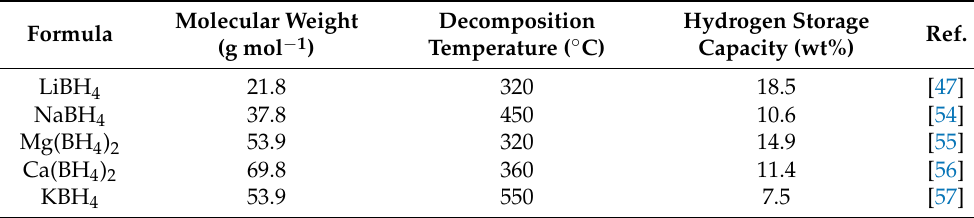
Table 1. Thermal and hydrogen storage properties of metal